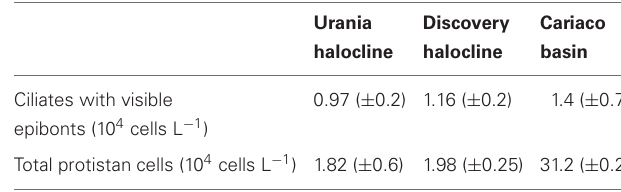
Table 2 | The abundance of two ciliate morphotypes containing epibiotic bacteria compared to total protistan